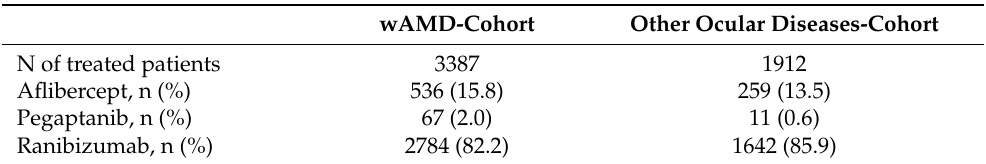
third year. As reported in Figure 2 and in Supplementary Table S1, the mean annual number of prescriptions for all drugs significantly ( p < 0.001) decreased during the follow-up period: the overall value ranged 3.6 ± 2.0 during the first year, 1.1 ± 1.8 in the second year, and 0.8 ± 1.7 during the third